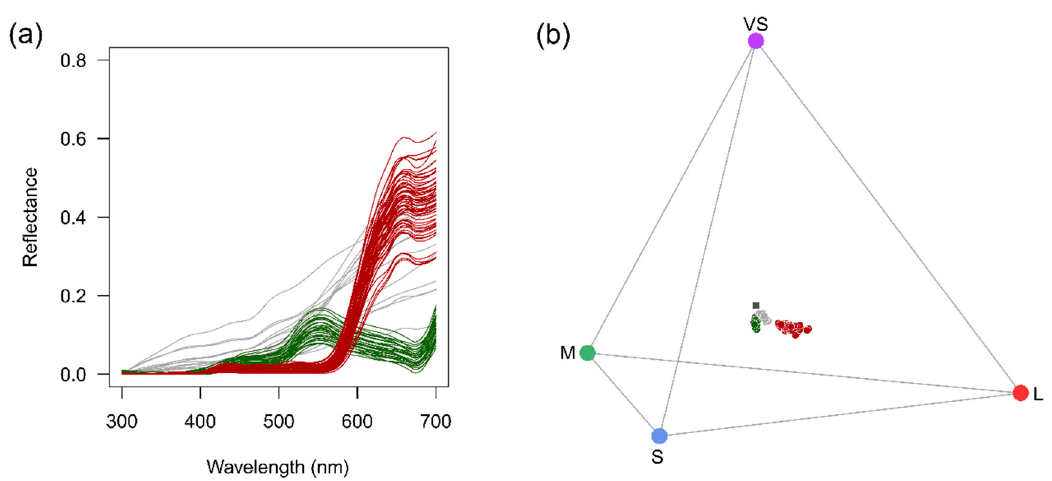
Figure 6. ( a ) Spectral reflectance of ray florets and leaves of M. subulata and of stones against which flower-heads are likely to be detected by pollinators given the low disposition of the flower-heads. ( b ) Distribution of ray floret, leaf and stone colours in the avian tetrahedral space considering the standard avian colour vision system with VS, S, M and L type cones which correspond to cones maximally sensitive to violet, blue, green and light red, respectively. Lines and symbols: red = ray florets; green = foliage; grey = stones.